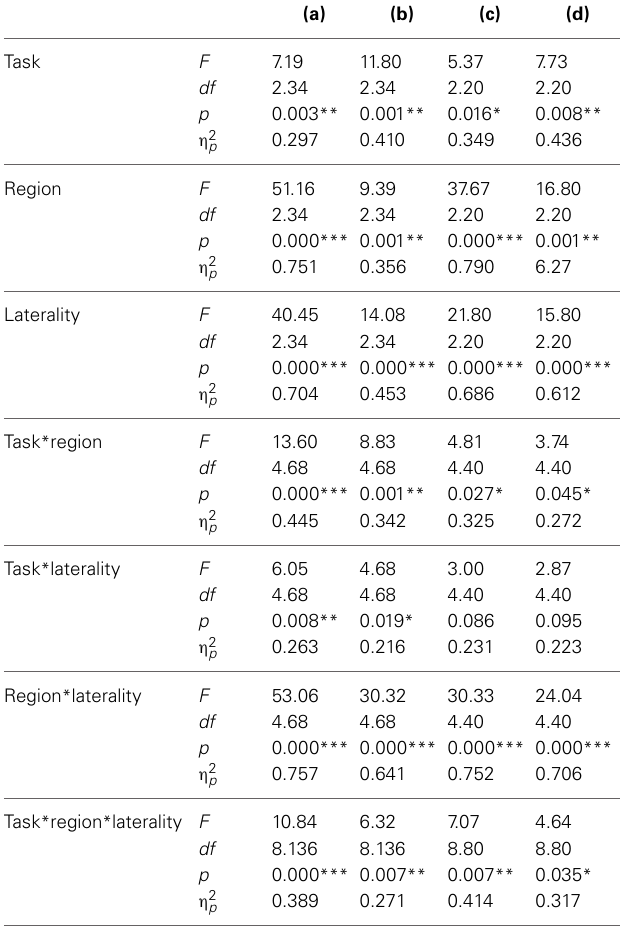
Table 3 | Oddball